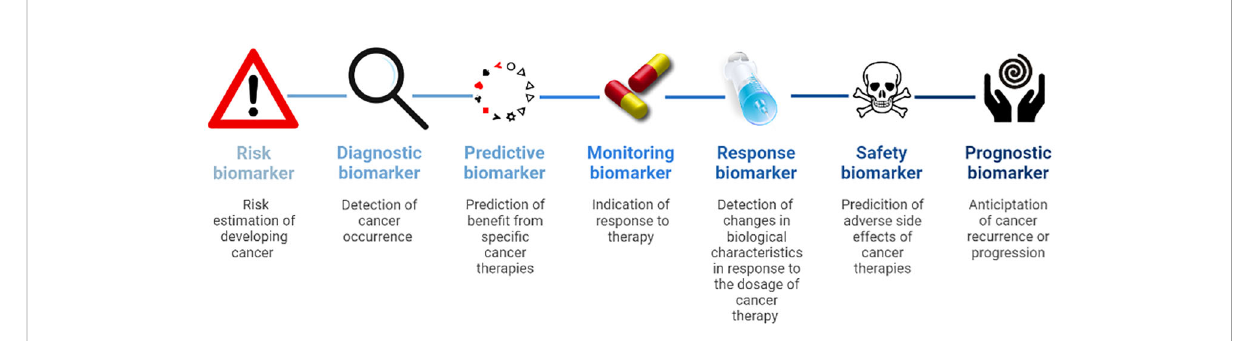
FIGURE 1 Overview of biomarker